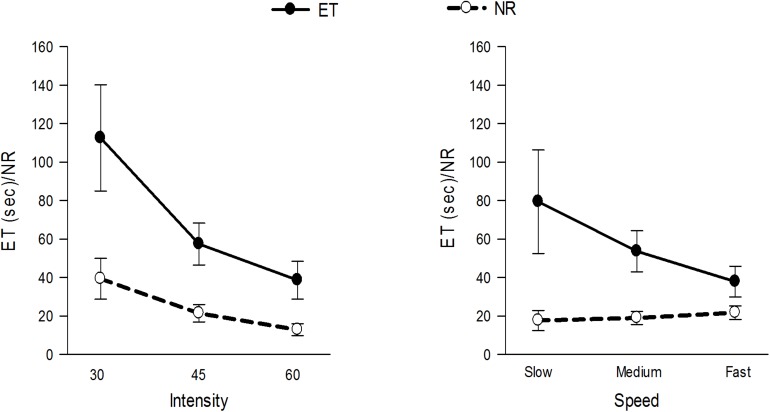
μ(SD) of the ET and NR at 30, 45, and 60% 1RM and at slow, medium and fast speeds.